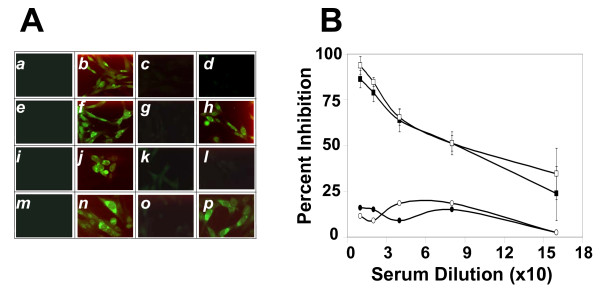
Simultaneous induction of antibodies that recognize and neutralize DEN virus serotypes 2 and 4. (A) IFA of DEN virus-infected cells using murine antisera. BHK cells were either mock infected (panels a, e, i and m) or infected separately with DEN-1 (panels b, c, d), DEN-2 (panels f, g, h), DEN-3 (panels j, k, l) and DEN-4 (panels n, o, p) viruses. One day after infection, cells were fixed and probed separately with different antisera as the source of primary antibodies. The antisera were obtained from mice, immunized with purified recombinant proteins [rEDIII-1 (panels a, b), rEDIII-2 (panels e, f), rEDIII-3 (panels i, j), and rEDIII-4 (panels m, n)] and rAd/plasmid [rAd-C/pVAX1 (panels c, g, k, o) or rAd-Bg/pVAX-EDIII-4/2 (panels d, h, l, p)]. The resultant virus/antibody complexes were visualized using anti-mouse IgG-FITC conjugate. (B) LLCMK2 monolayers were separately infected with each of the four DEN viruses (DEN-1: filled circles; DEN-2: filled squares; DEN-3: open circles; & DEN-4: open squares) that had been pre-incubated with serial two-fold dilutions of pooled immune serum drawn from the rAd-Bg primed/plasmid pVAX-EDIII-4/2 boosted animals. The resultant plaque counts, expressed as percent inhibition of virus infectivity (with reference to the number of plaques generated in the absence of antiserum, which was taken to represent 100% infectivity) are plotted as a function of antiserum dilution. Each data point shown represents the mean of four replicate assays (the error bars represent SD).